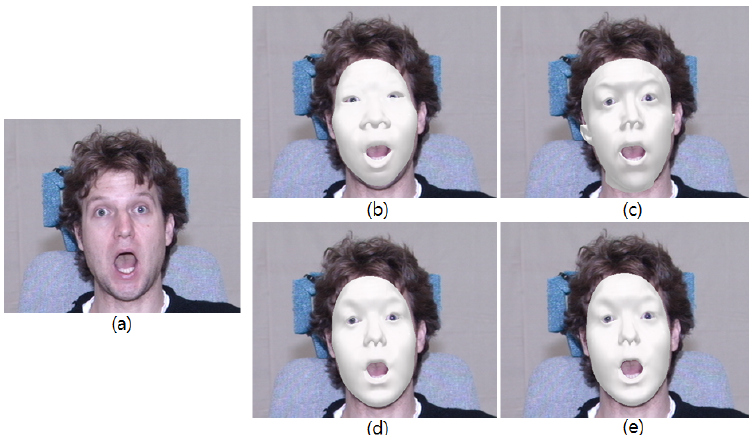
Figure 2. Fitted shapes with different numbers of identities: ( a ) Input image. ( b ) Fitted meshes with 10 identities of 47 expressions. ( c ) 50 identities of 47 expressions. ( d ) 100 identities of 47 expressions. ( e ) 150 identities of 47